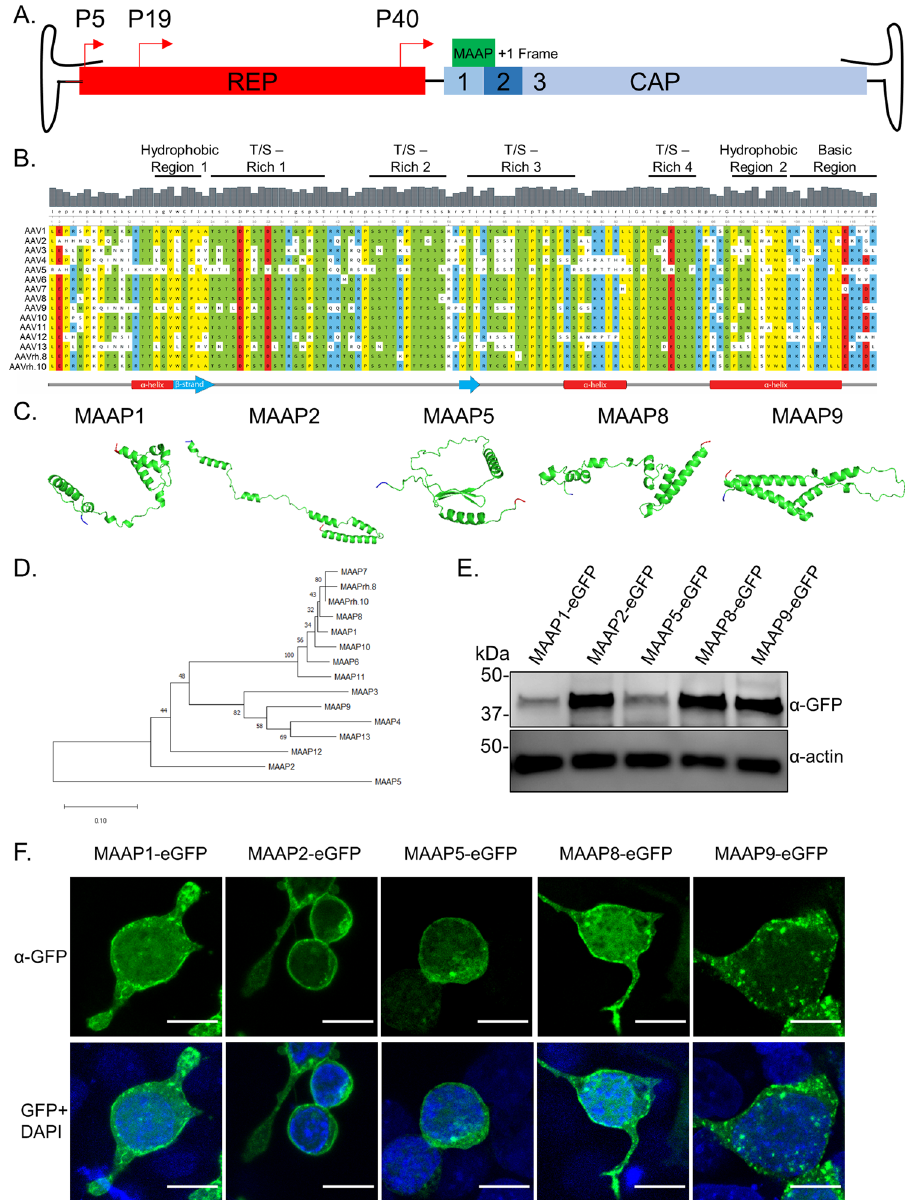
Fig. 1 MAAP is a unique virally encoded protein with an amphipathic, cationic membrane anchoring domain. A WT AAV genome showing Rep and Cap genes with MAAP encoded in a + 1 open reading frame in the VP1 region. B Sequence alignment of the MAAPs from AAV serotypes 1 to 13 along with AAVrh.8 and AAVrh.10. An annotated multiple-sequence alignment of the AAP sequences of 15 AAV serotypes is shown. Coloring re fl ects the physicochemical properties of the residues (Yellow = hydrophobic, Green = polar, Blue = basic, Red = acidic). Regions of interest are annotated above the alignment. Predicted secondary structural (SS) elements (strand, helix) for the sequence and amino acid numbering are displayed below the alignments. C Structural models of MAAP1, MAAP2, MAAP5, MAAP8, and MAAP9 generated using Robetta Structural Prediction Server. Residues highlighted in blue indicate N-terminus and residues in red indicate C-terminus. D Neighbor-joining phylogeny of MAAP amino acid sequences from AAV serotypes 1 to 13, MAAPrh.8 and MAAPrh.10. MAAP amino acid sequences were aligned with ClustalW, the phylogeny was generated using a neighbor-joining algorithm, and a Poisson correction was used to calculate amino acid distances, represented as units of the number of amino acid substitutions per site. The tree is drawn to scale, with branch lengths in the same units as those of the evolutionary distances used to infer the tree. Bootstrap values were calculated with 1000 replicates, and the percentage of replicate trees in which the associated taxa clustered together are shown next to the branches. E Anti-GFP immunoblot of whole-cell extracts prepared from HEK293 cells expressing indicated GFP tagged constructs. Anti-actin immunoblot served as loading control. Immunoblot is a representative image of four independent experiments. F Confocal images of HEK293 cells overexpressing eGFP tagged MAAP constructs. Scale bar = 10 μ M. Micrographs are representative images of three independent blot con fi rmed these results with undetectable to relatively lower when comparing the transduction ef fi ciency of rAAV8 and levels in the extracellular fraction on days 3 and 5, respectively, MAAP Δ particles in vitro (Fig. 2I). Furthermore, MAAP Δ and correspondingly high(er) cellular retention in case of recombinant virus showed similar VP1, VP2, and VP3 expression MAAP Δ particles (Fig. 2G, H). No differences were observed ratios and overall virus morphology compared to rAAV8